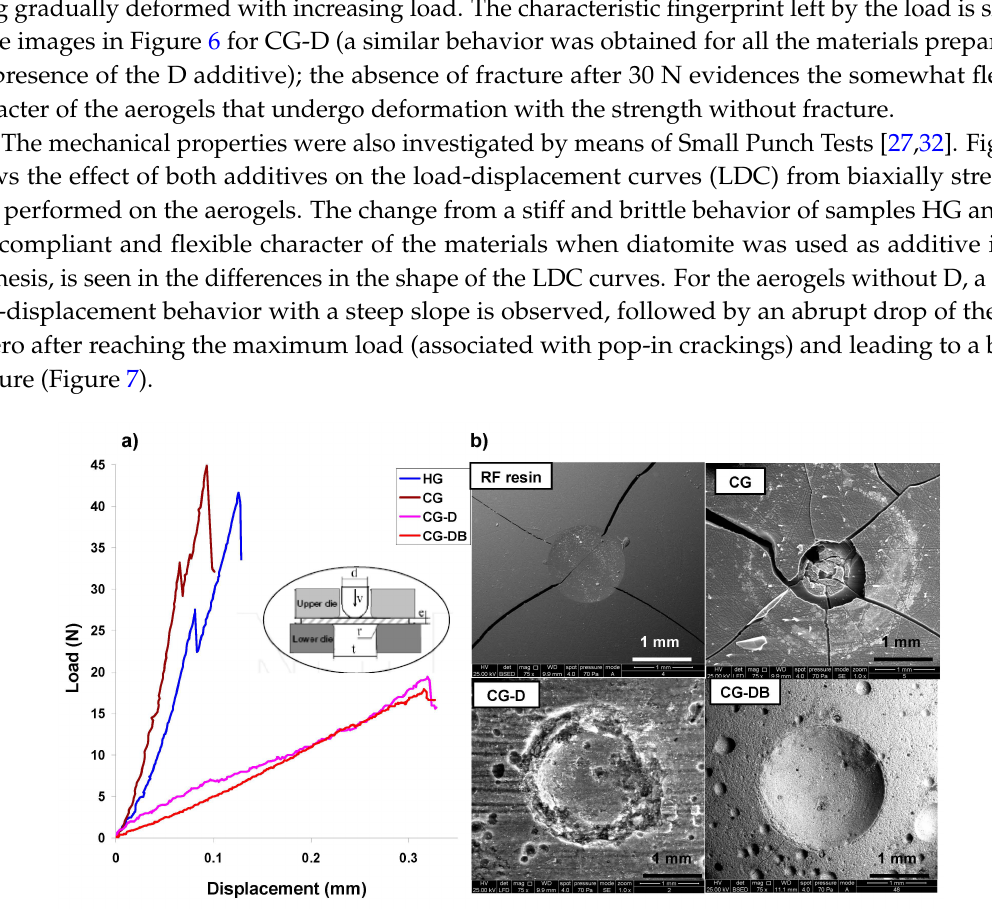
Figure 7. ( a ) Load-displacement curves (LDC) of the aerogels determined by the Small Punch Tests under quasi-statical conditions (inset); ( b ) Characteristic fingerprint of the fracture after the Small Punch Tests on the aerogels (data of a brittle facture on a phenol-formaldehyde resin is also included for comparison